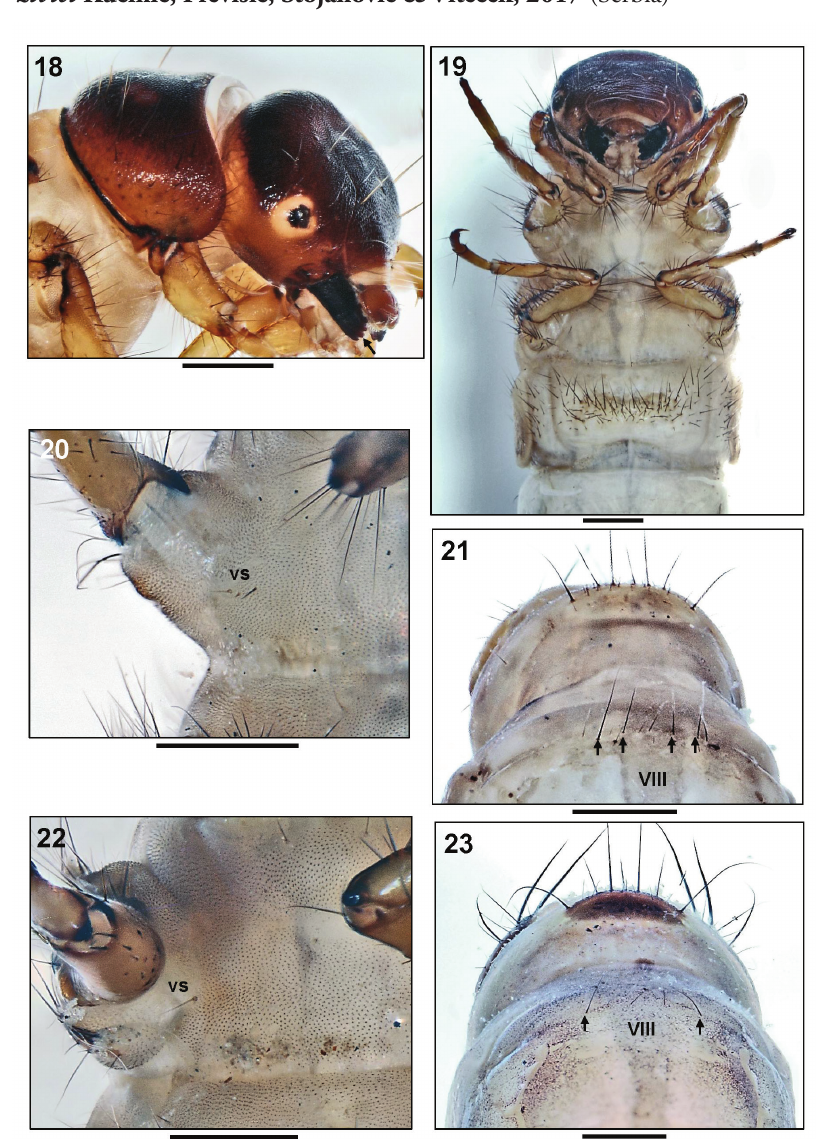
right lateral view (arrow: mandibles with terminal teeth) 19 Head, thorax and abdominal segment I, ventral view 20 Detail of mesosternum, ventral view (vs: ventral setae) 21 Tip of abdomen, dorsal view (arrows: long posterodorsal setae). 22–23. Drusus franzi Schmid, 1955, 5 th instar larva. 22 Detail of mesosternum, ventral view (vs: ventral seta) 23 Tip of abdomen, dorsal view (arrows: long posterodorsal setae). Scale bars: 0.5